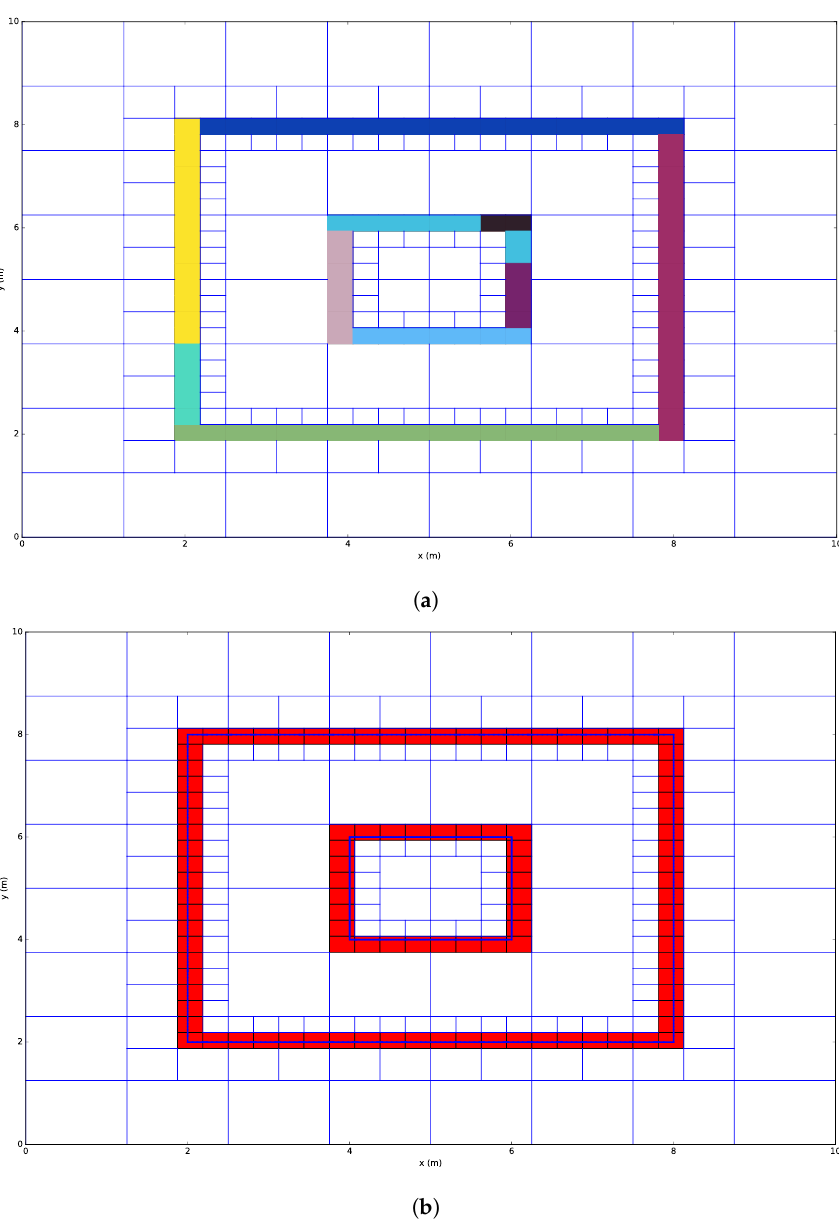
Figure 6. Clustering + line segment extraction. ( a ) overview of region growing based line extraction; ( b ) line